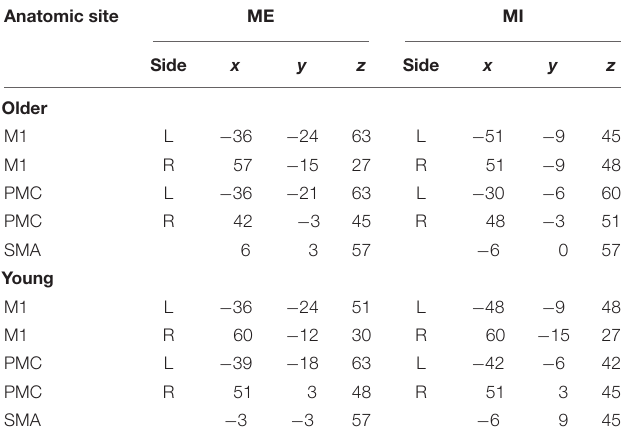
TABLE 1 | The MNI coordinates of the center of the